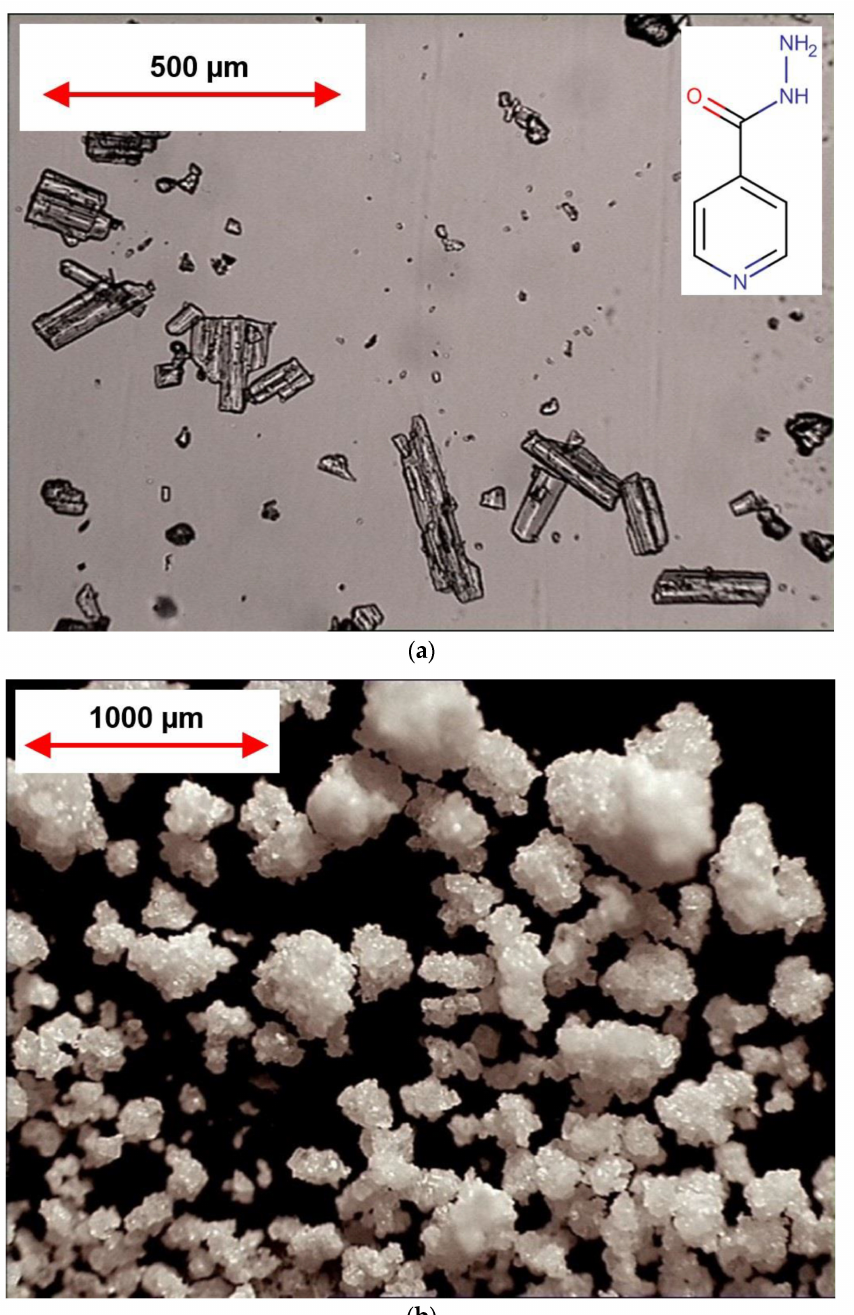
Figure 3. Light microscopy images of raw (( a ); transmitted light/bottom highlighting) and granulated (( b ); reflected light/top highlighting)